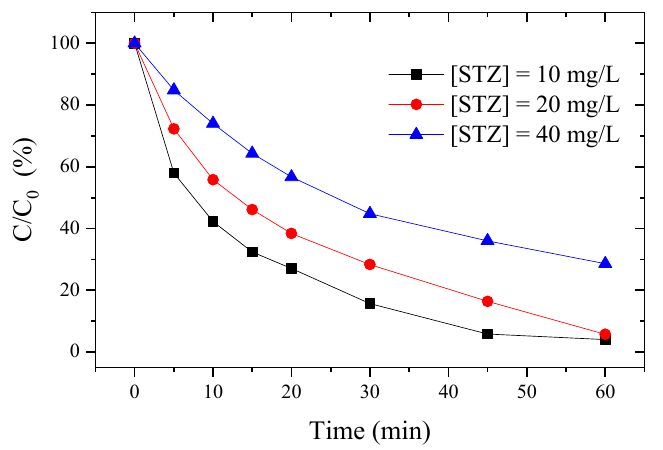
Figure 3. Effects of STZ concentration on STZ removal. Conditions: [STZ] = 10–40 mg/L, [PDS] = 300 mg/L and UV irradiation: 2 mW/cm 2 .